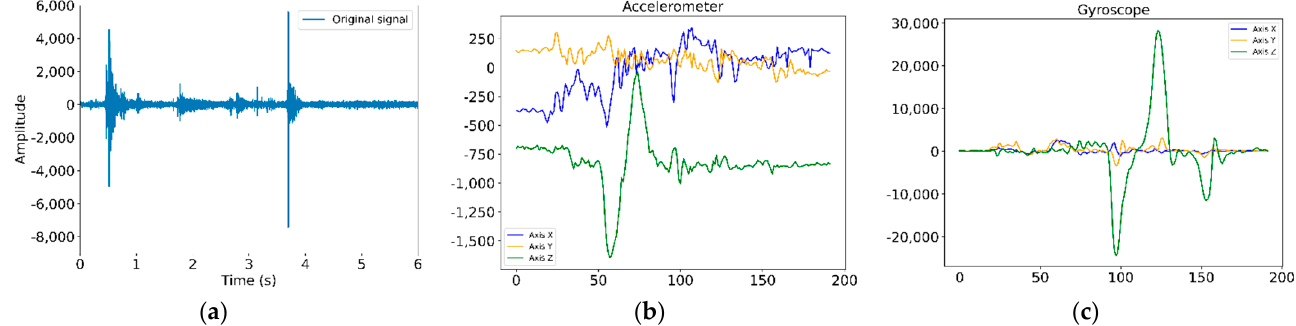
Figure 3. Signals: ( a ) acoustic signal obtained, ( b ) 3 axis accelerometer values obtained, ( c ) 3 axis gyroscope values obtained.